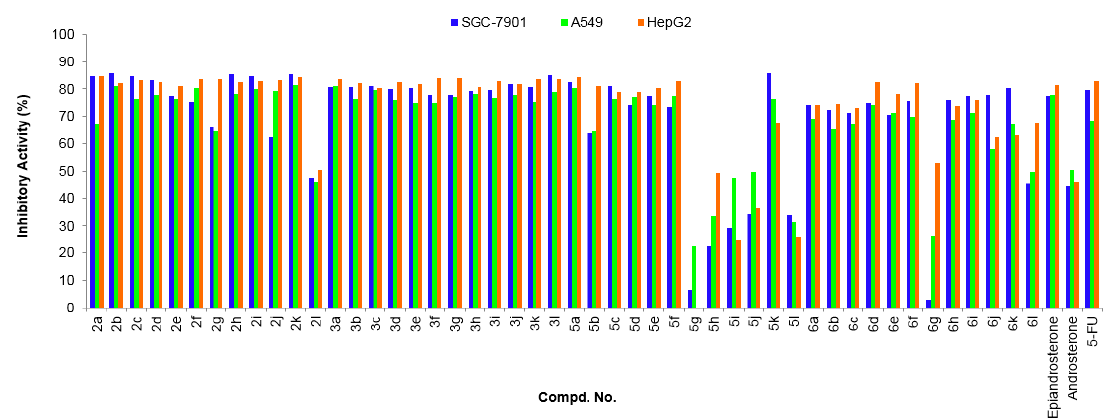
Figure 3. Antitumor activities of compounds 2a – l , 3a – l , 5a – l , and 6a – l at 40 µ g/mL. Abbreviations: SGC-7901—Human gastric cancer cell line, A549—Human lung adenocarcinoma cell line; HepG2— human hepatocellular liver carcinoma cell line; 5-FU—5-Fluorouracil, used as a positive control.